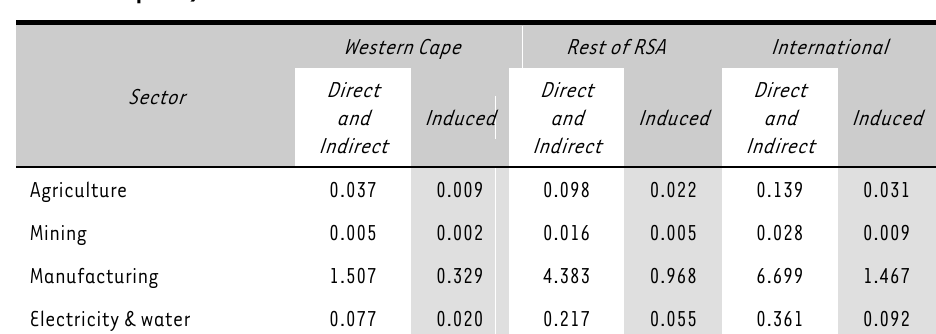
Direct, indirect and induced impact of spending on production (in ZAR millions, 2006